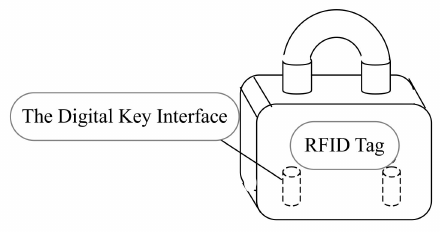
Figure 4. The RFID lock system.